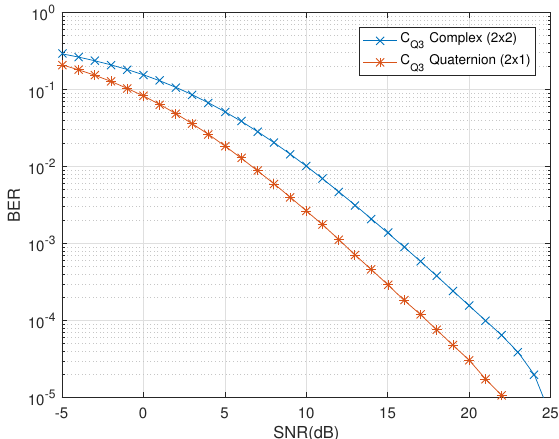
Figure 6. BER vs. SNR performance comparison of C Q quaternionic channel-based decoder.